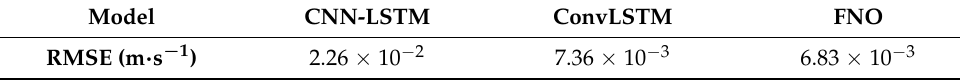
Table 2. Impact of mass conservation weights on validation RMSE obtained by all optimized model architectures after a maximum of 300 epochs.